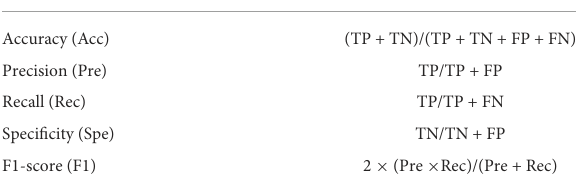
TABLE 2 Evaluation